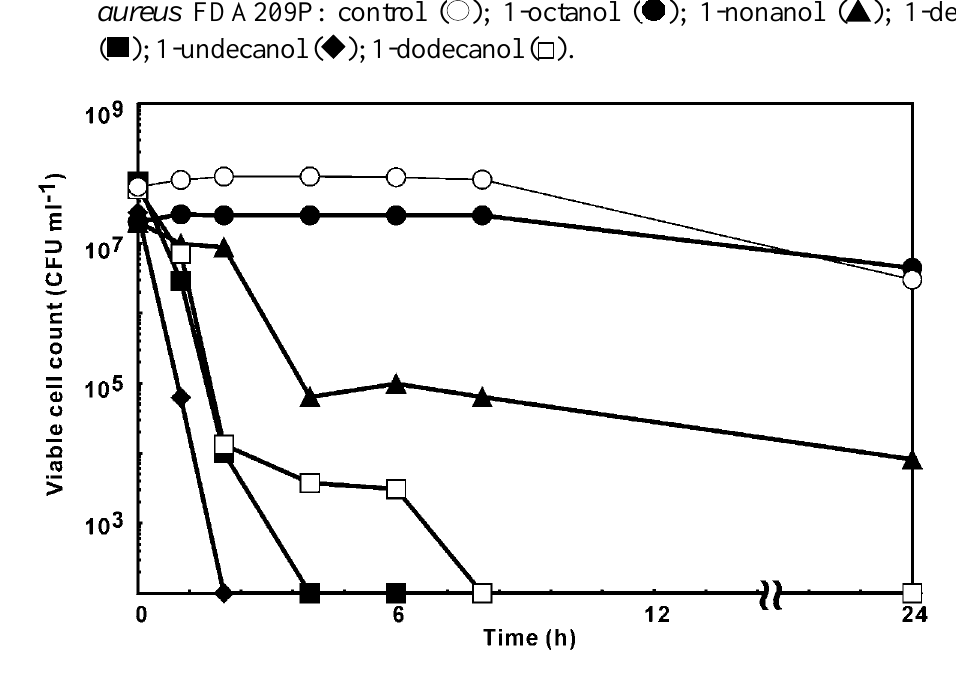
Figure 3. Assays of the toxic effects of 80 µ g mL -1 long-chain fatty alcohols on S. aureus FDA209P: control ( ); 1-octanol ( ); 1-nonanol ( ); 1-decanol ( ); 1-undecanol ( ); 1-dodecanol (